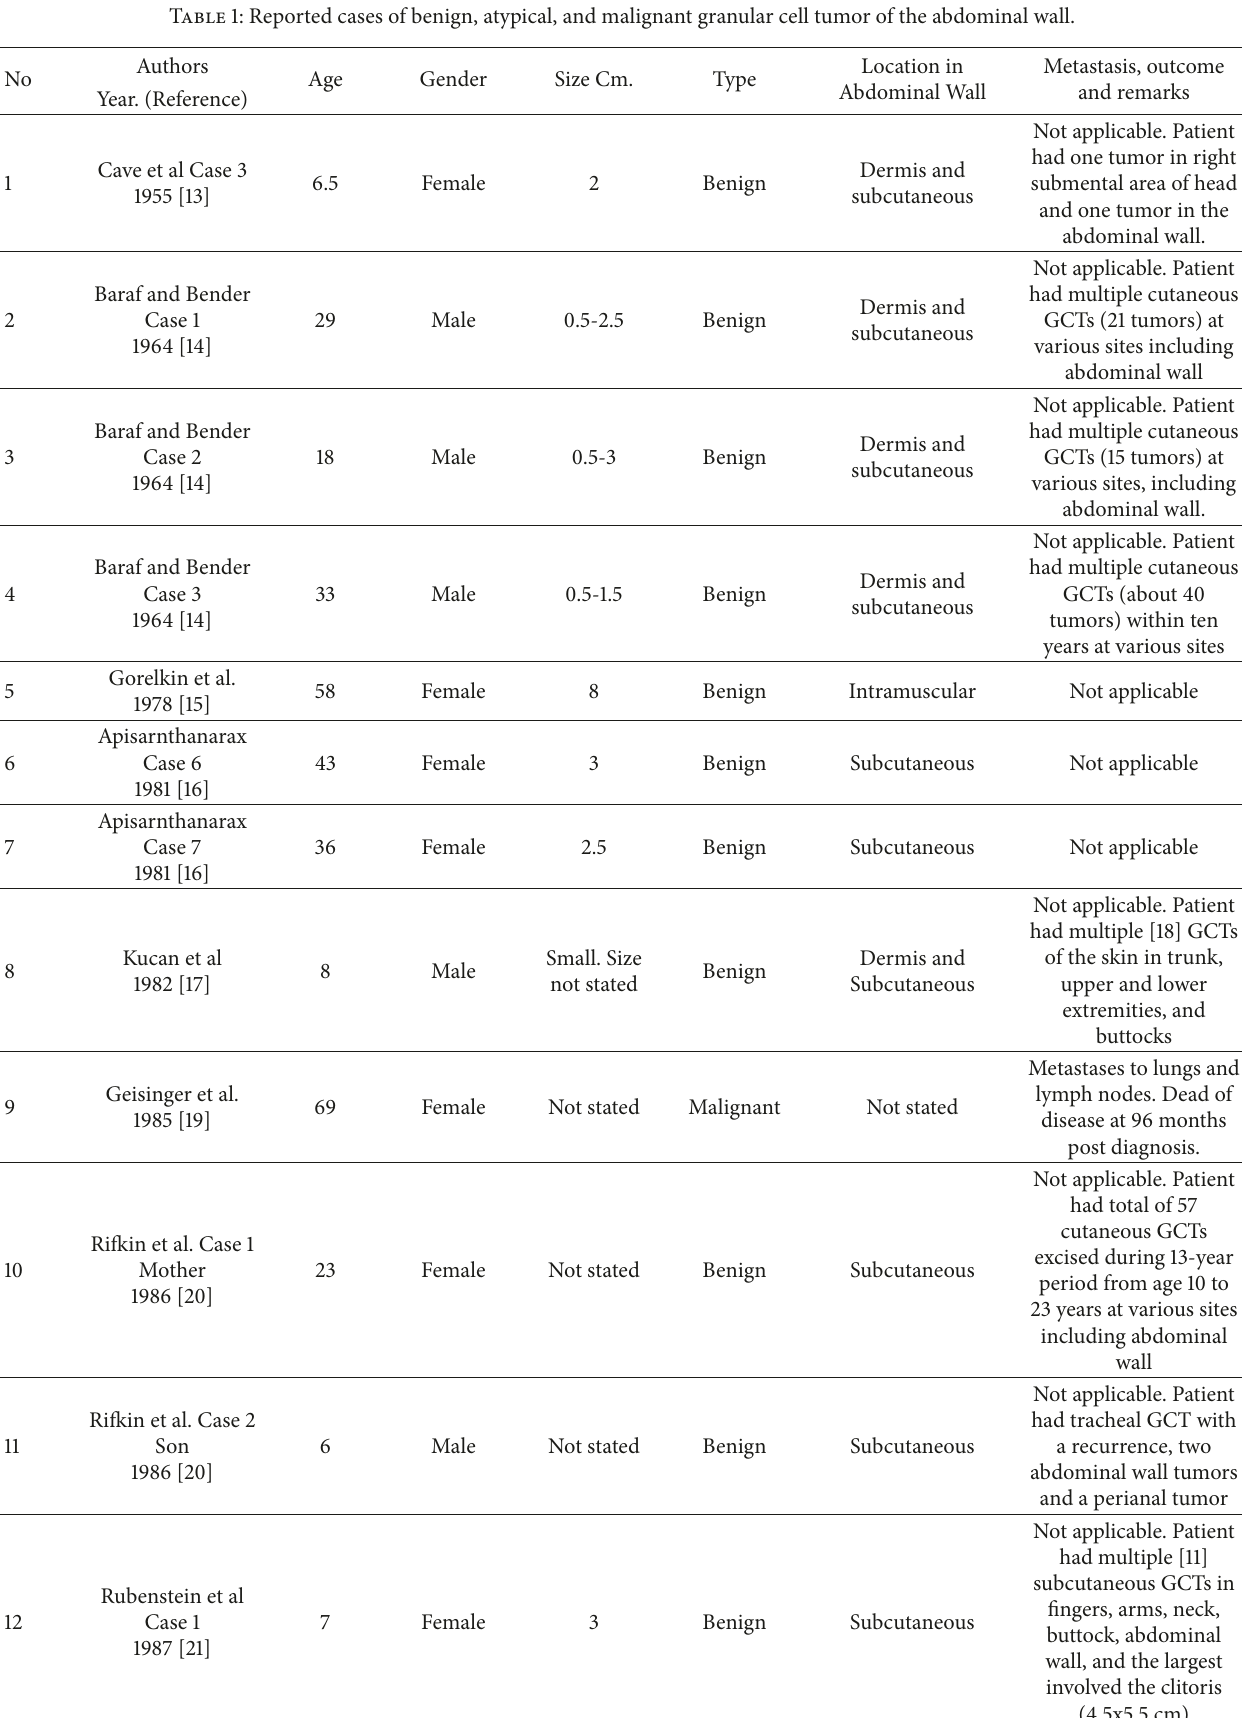
Table 1: Reported cases of benign, atypical, and malignant granular cell tumor of the abdominal